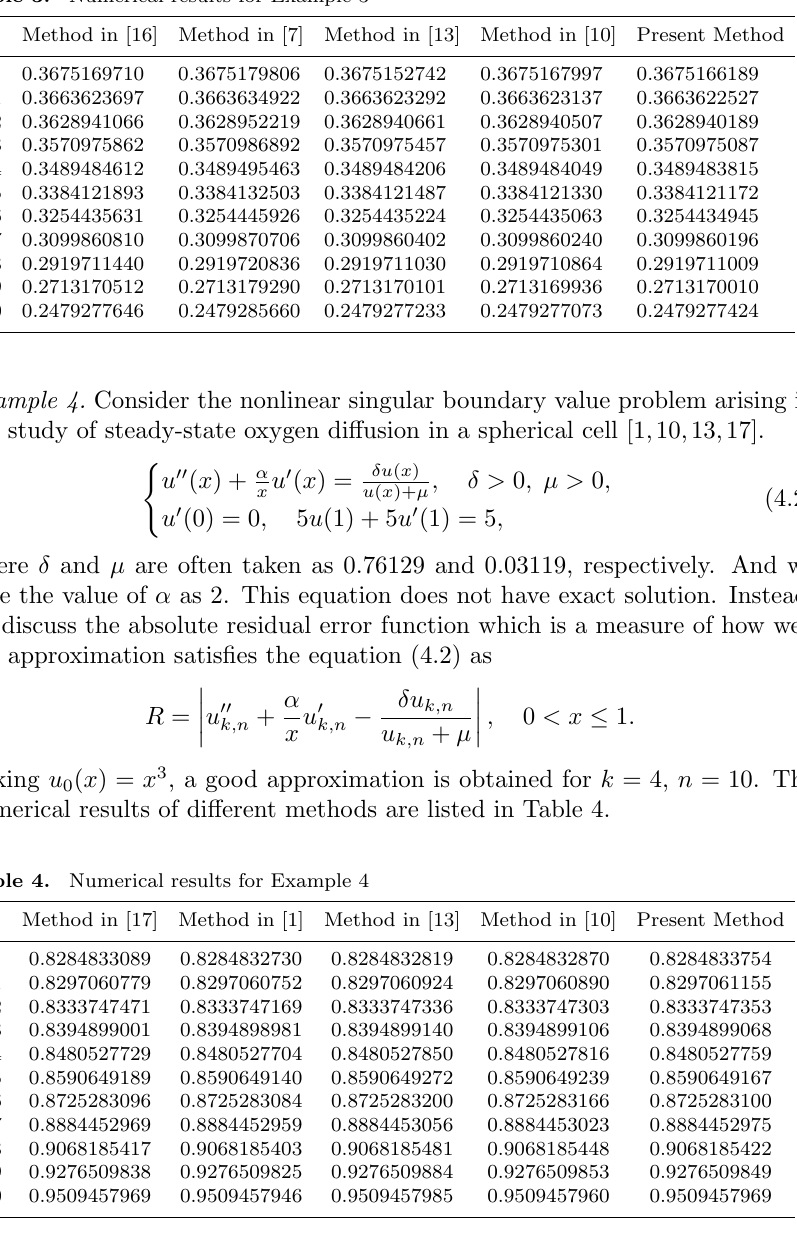
Table 3. Numerical results for Example 3